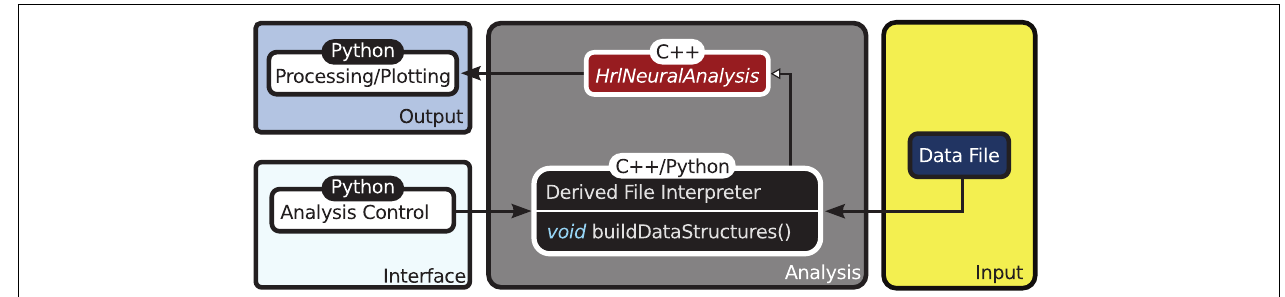
theconversionofthedatafileinputintothetwocorestructures.Theseclasses are responsible for implementing the buildDataStructures virtual function. The access control and visualization is then provided through the Python interface.